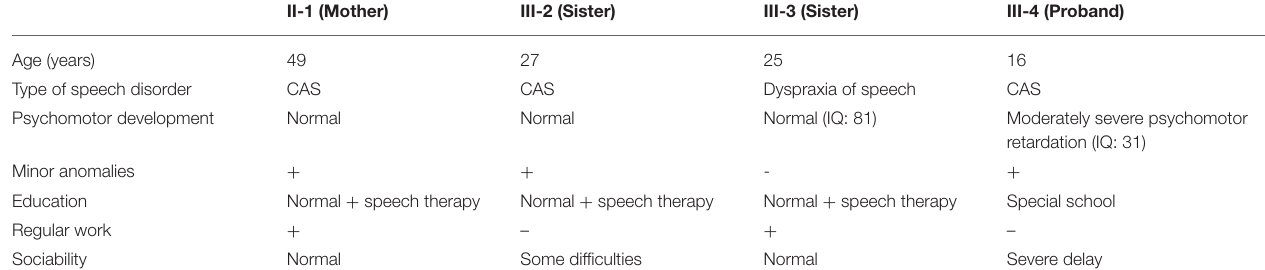
TABLE 1 | Clinical features of the affected family members and detailed developmental evaluation of the proband.